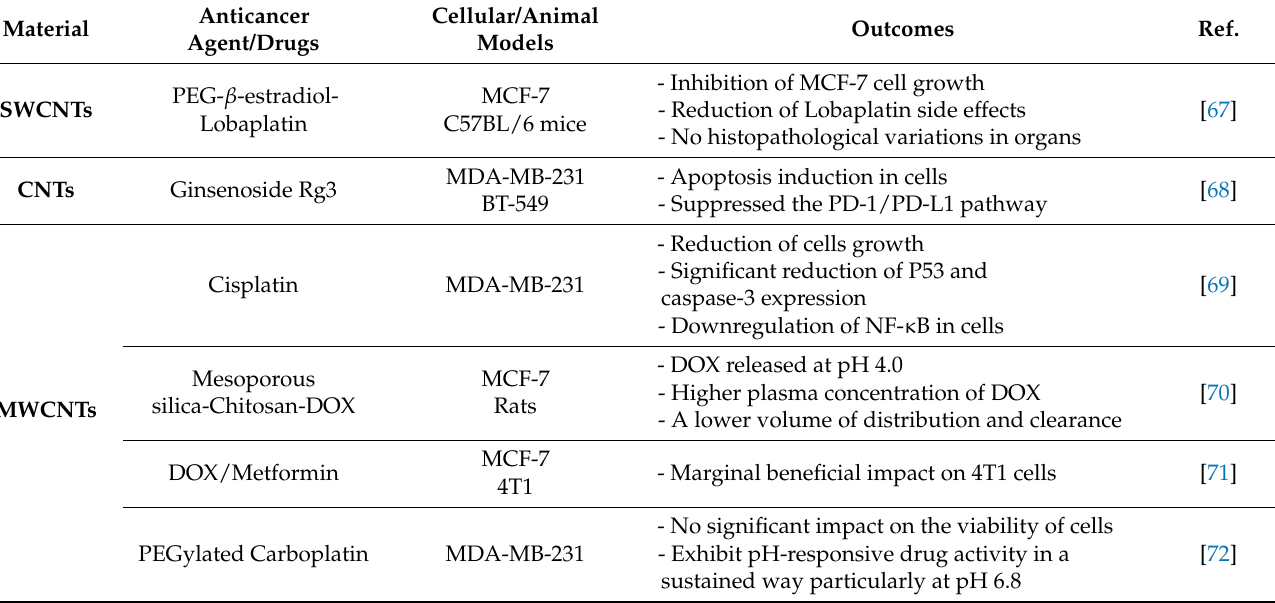
Table 2. Studies evaluating the therapeutic impact of CNT complexes on breast cancer